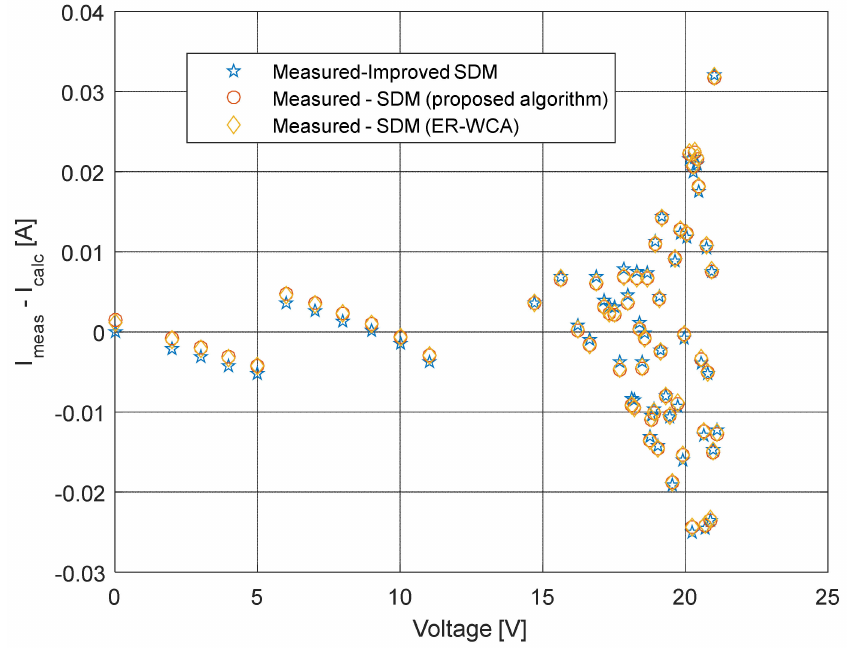
Figure 21. Difference between the measured and calculated current values using different methods for both SDM and ISDM.